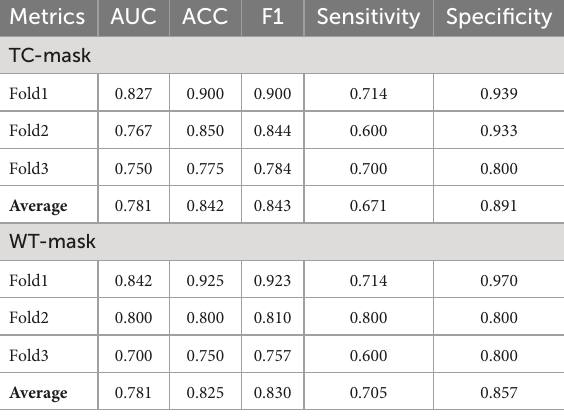
TABLE 2 Network performance in determining FRG